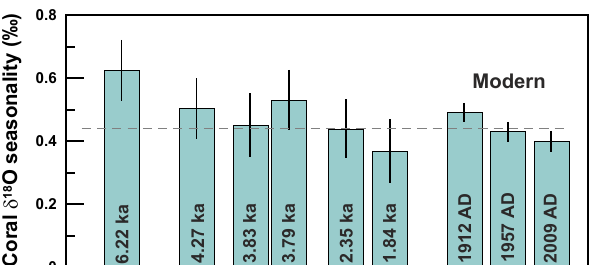
Fig. 4. Coral δ 18 O seasonality calculated for individual Bonaire coral records. Dashed line represents the mean modern δ 18 O sea- sonality (0.440‰) calculated from the mean seasonality of the three modern corals. Error bars for fossil corals are the combined error (root of the sum of the squares) of the standard deviation (2 σ ) from mean δ 18 O seasonality of three modern Diploria strigosa and the standard error (2SE) of the averaged δ 18 O seasonality measure- ments for individual coral records, following established procedures (Abram et al., 2009) but applied to reconstructed seasonality. Error bars for modern corals are 2SE. Note that the 6.22ka coral shows significantly increased δ 18 O seasonality compared to that given by three modern